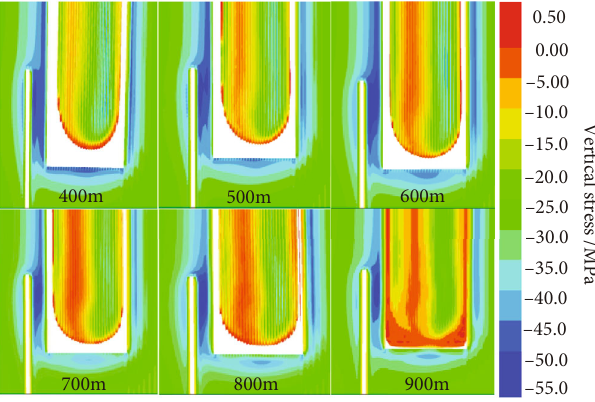
Figure 14: Vertical stress distribution with di ff erent buried